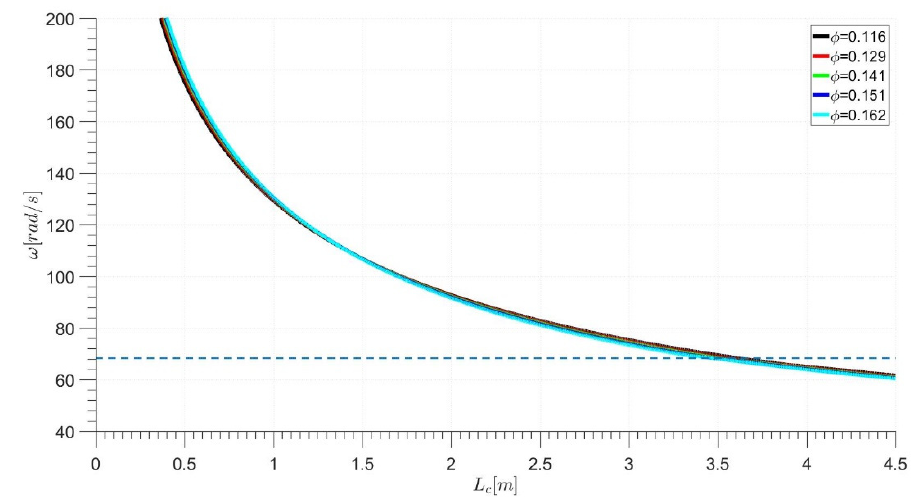
Figure 9. Pressure oscillations frequency for different operational points and L c parameter value.